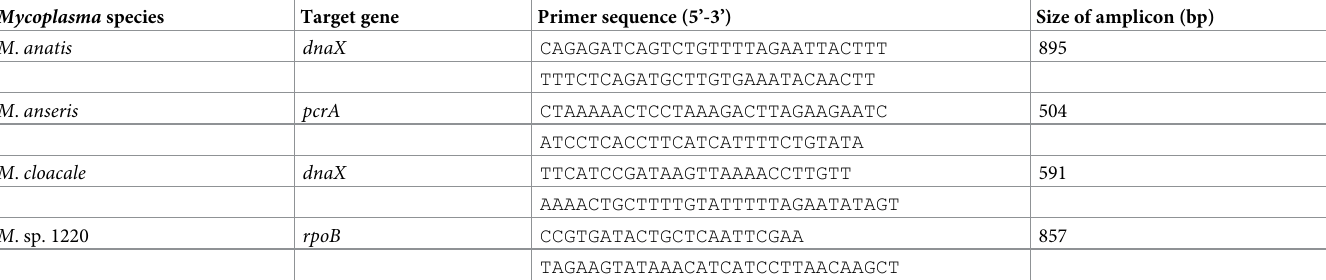
Table 3. Primers’ sequences and sizes of amplicons for the designed species-specific PCR assays. Mycoplasma